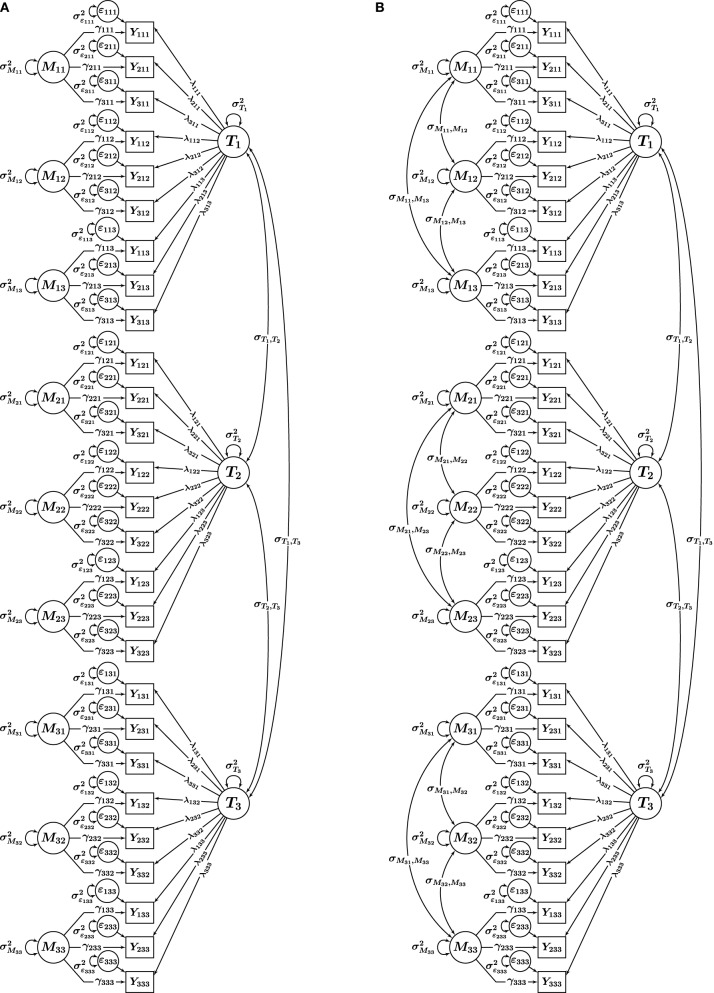
CFA-MTMM models for a design with i = 1, 2, 3 indicators, t = 1, 2, 3 traits, and m = 1, 2, 3 methods. (A) CT-UMunconstrained. (B) CT-CM. Yitm, observed variables; Tt, trait factors; Mtm, trait-specific method factors; ϵitm, measurement error variables; λitm, trait factor loadings; γitm, method factor loadings.